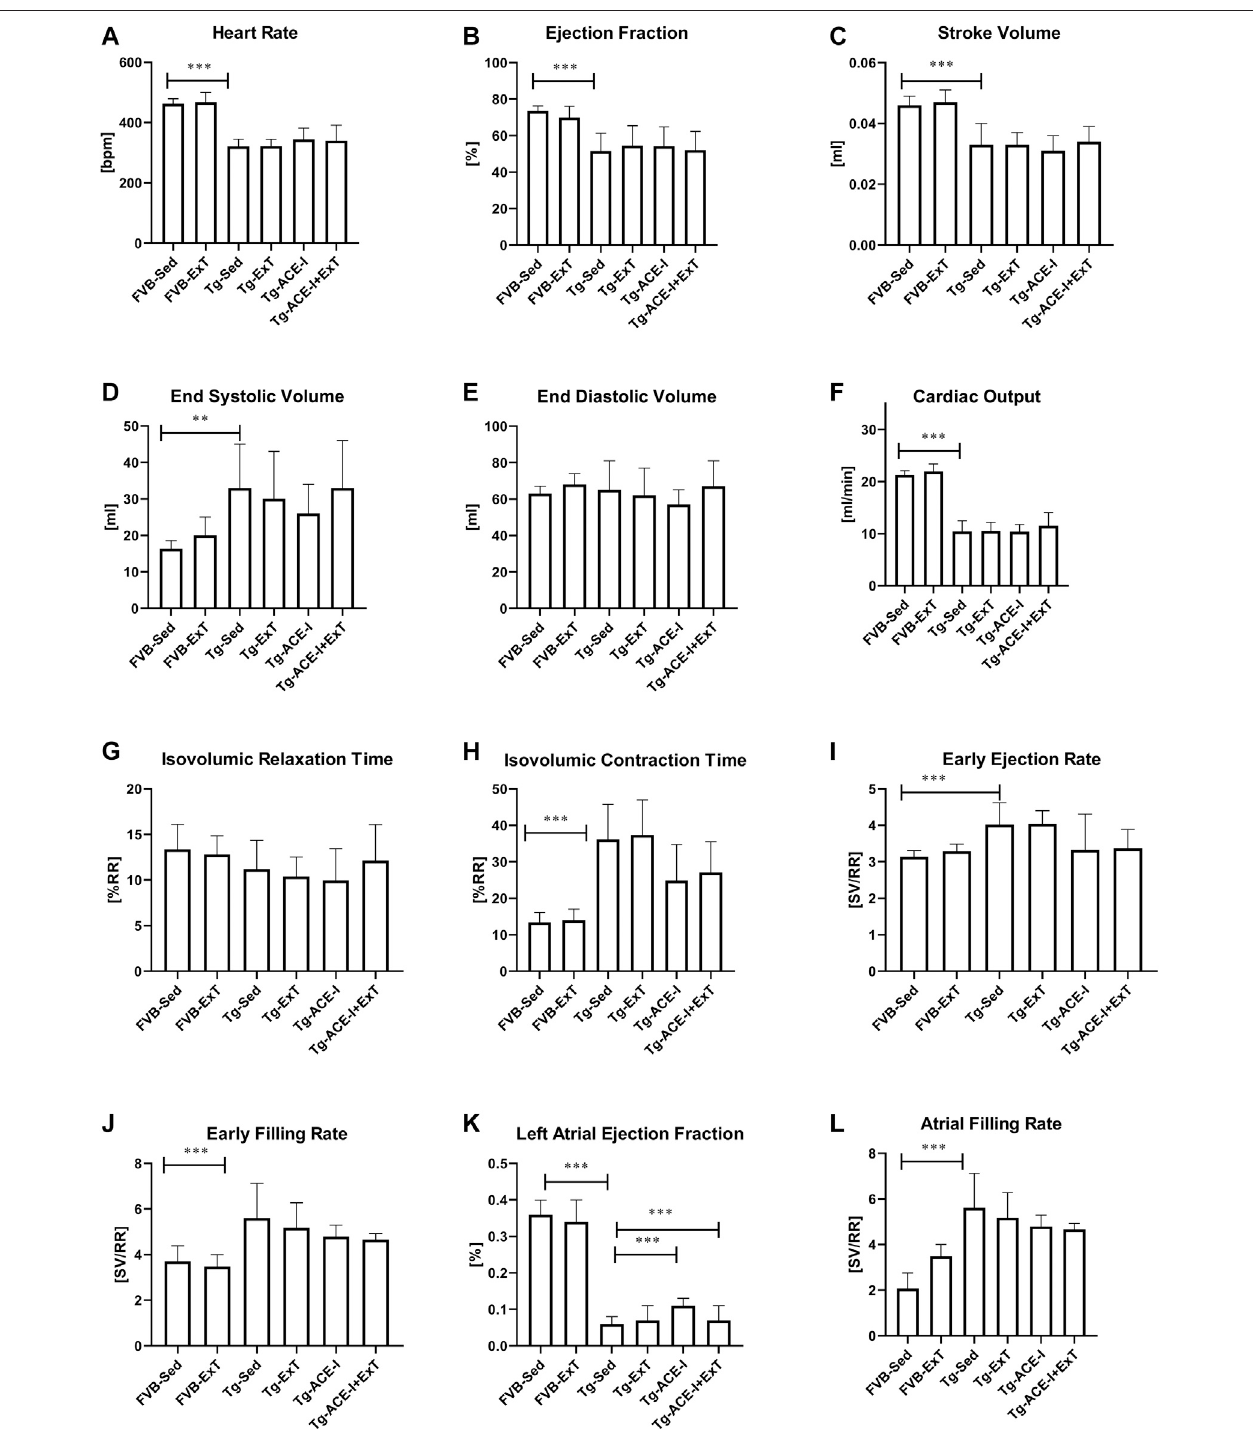
FIGURE 2 | Cardiac function in FVB and Tg α q*44 mice at the end-stage of HF after 8 weeks of treatment [ExT or ExT+ therapy (ACE-I)]. The differences between FVB controls and Tg α q*44 mice (nonrunning and nontreated) were observed in heart rate (A) , ejection fraction (B) , stroke volume (C) , end systolic volume (D) , cardiac output (F) , isovolumic contraction time (H) , early ejection and fi lling rate (I, J) , and atrial fi lling rate (L) . There was a difference in cardiac performance between Tg α q*44 mice with applied ACE-Itherapy and sedentaryTg α q*44 micein leftatrialejection fraction (K) . Further, therewasadifferencein leftatrialejection fraction between sedentary Tg α q*44mice withappliedACE-Itherapyandexercised,nontreatedTg α q*44mice (K) .Nootheralterationswereobservedbetweensedentaryandexercisedmice(treatedornot)fromeach group (E, G) . Sed-sedentary; ExT-exercised; data presented as mean ± SD; n (cid:1) 7 – 12. ** p < 0.01, *** p < 0.001 for Tg α q*44 (Sed, control) vs. FVB (Sed, control) ( t test or Mann – Whitney test). † p < 0.05 for Tg α q*44 (Sed, control) vs. Tg α q*44 (Sed, therapy), ‡ p < 0.05 for Tg α q*44 (Sed, control) vs. Tg α q*44 (ExT, therapy), $ p < 0.05 for Tg α q*44 (Sed, therapy) vs. Tg α q*44 (ExT, control). Statistics within Tg α q*44 experimental groups: one-way ANOVA or Kruskal – Wallis test.